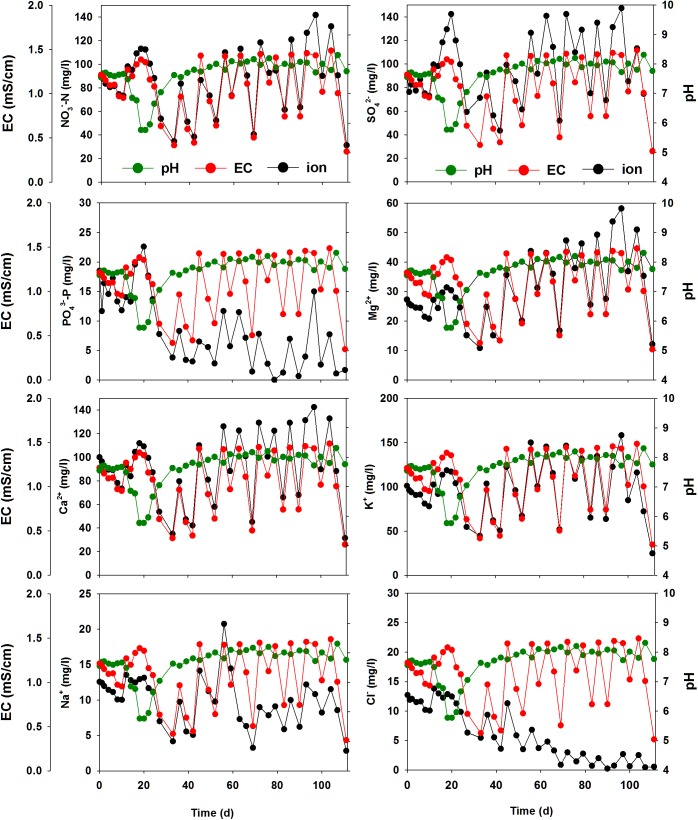
Variation in pH, EC, and major ions (NO3–-N, PO43–-P, Ca2+, SO42–, K+, Mg2+, Na+, and Cl–) during tomato growth in the closed hydroponic system.